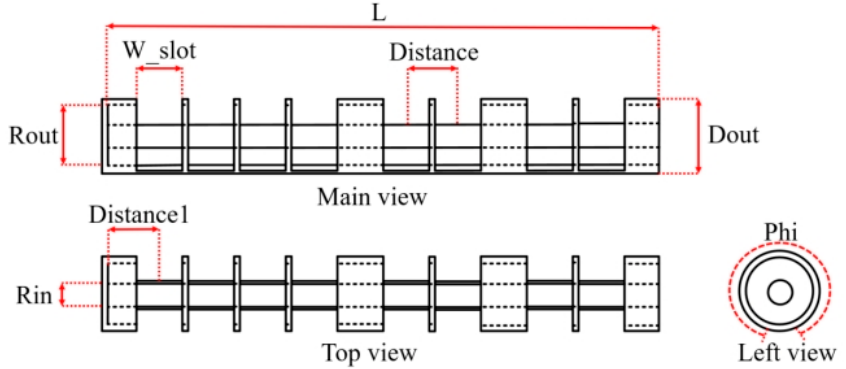
Figure 3. 2D top view, side view, and cross section of the structure.